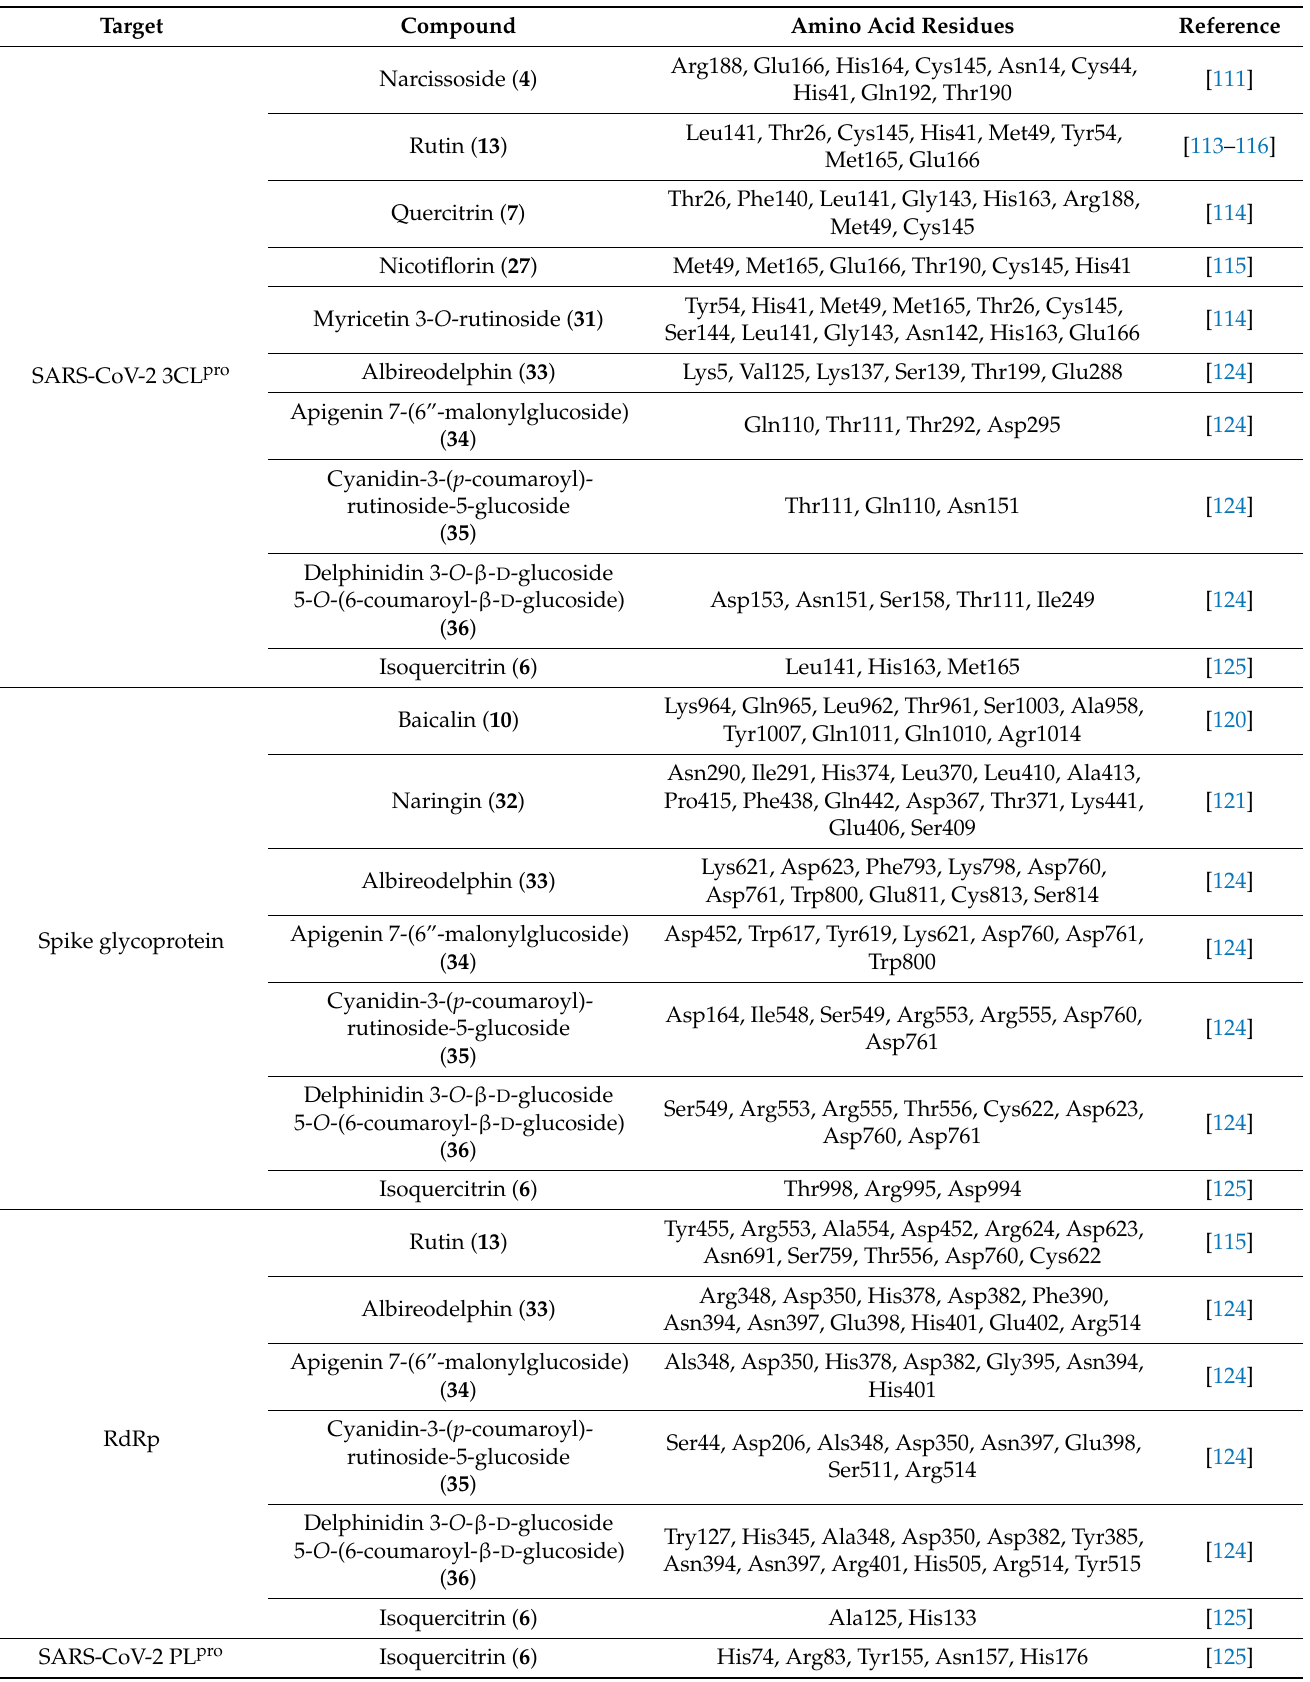
Table 3. Molecular docking analysis of anti-coronaviral glycosyl